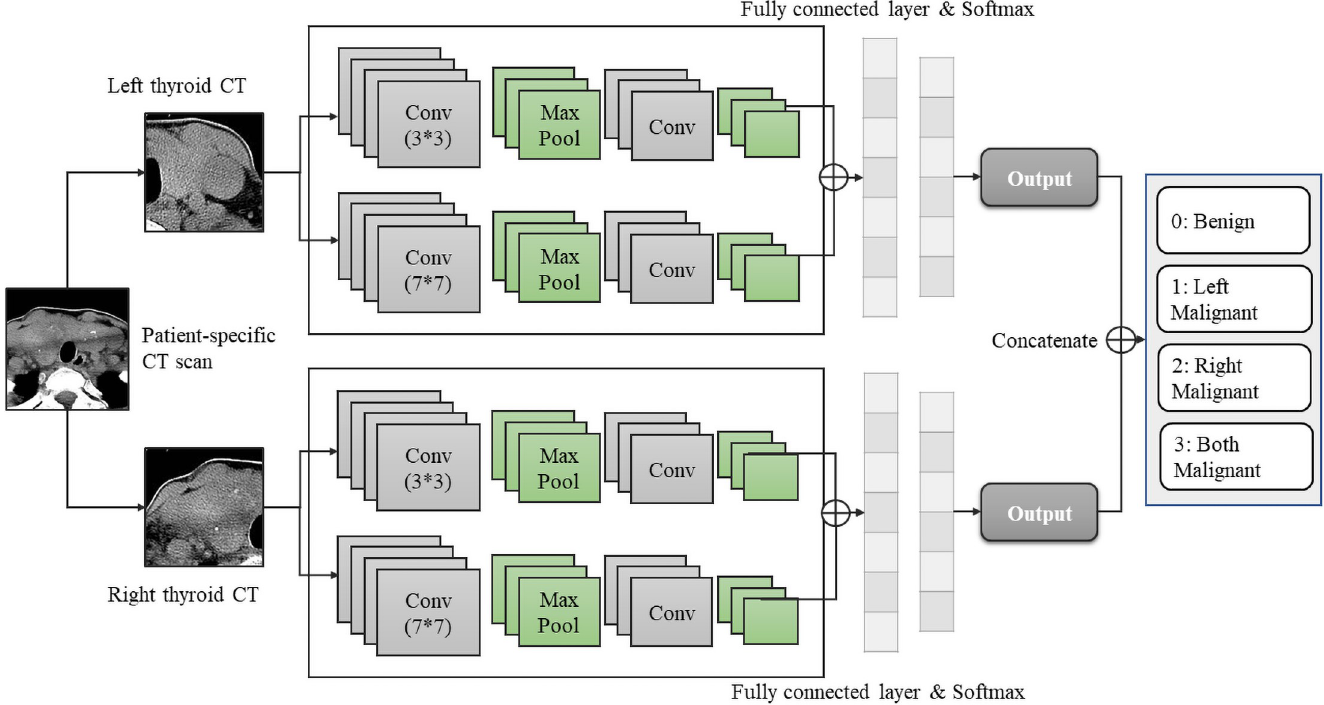
Fig 5. Double inputs dual-channel (four-channel)